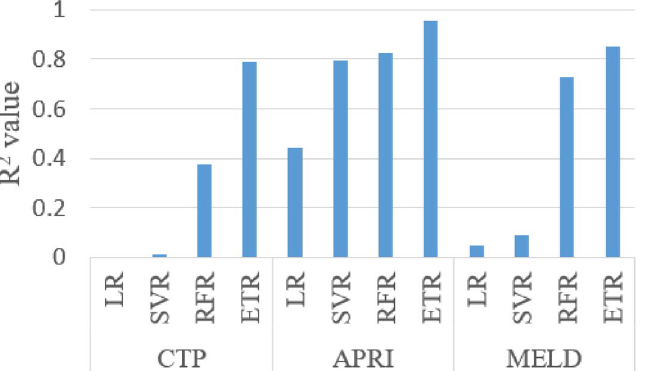
Figure 13. R 2 value of actual score to predicted score using four different regression method for CTP, APRI and MELD